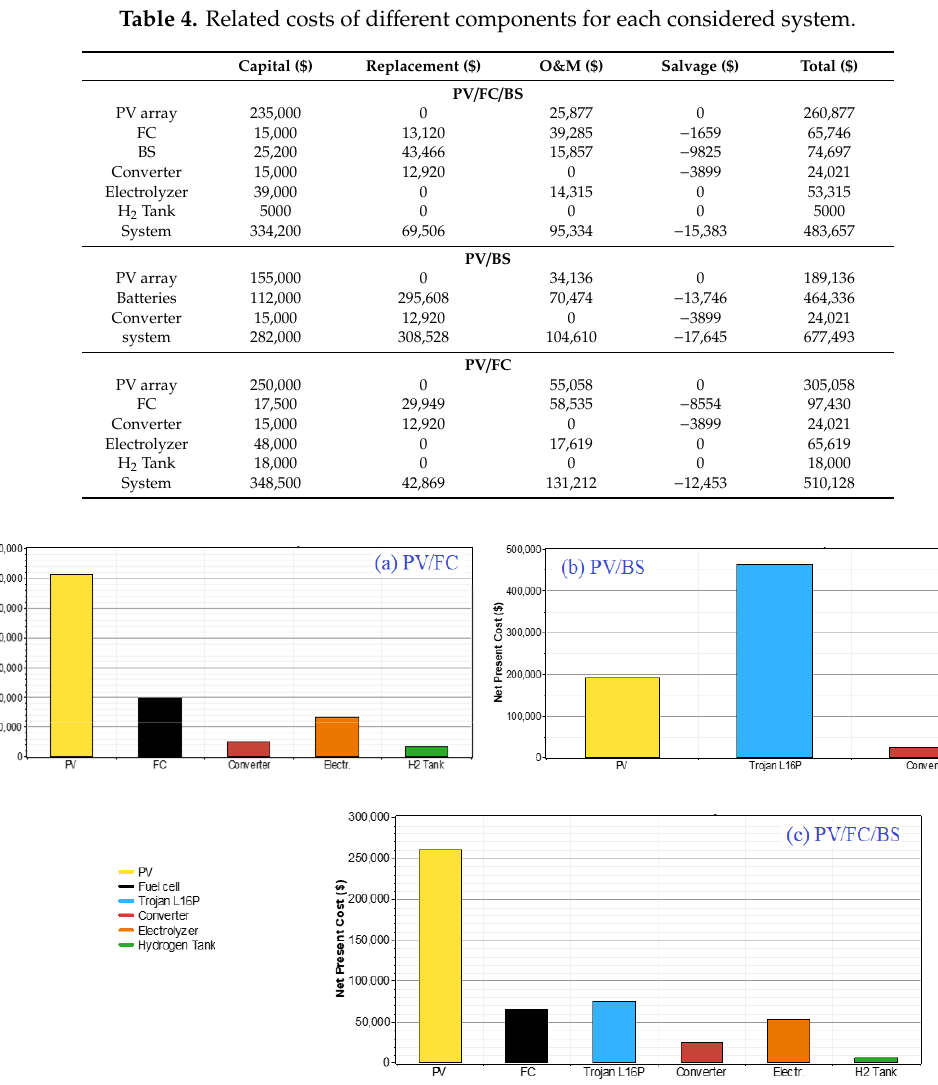
Figure 10. The net present cost for different system components.